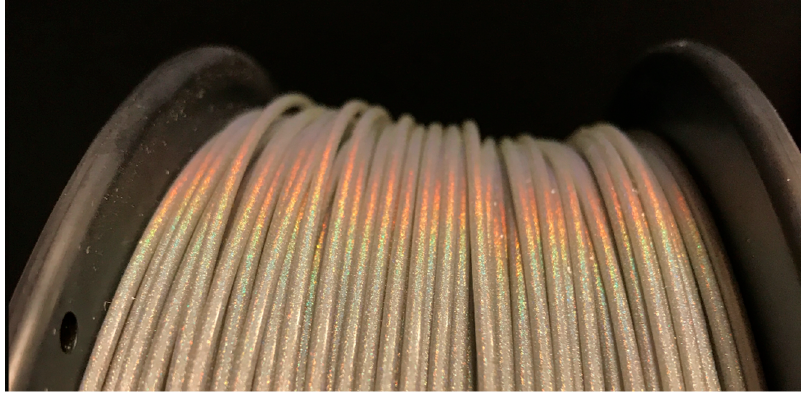
Figure 1. Picture of an ABS (acrylonitrile-butadiene-styrene copolymer) filament (MAXITHEN® SAN702767/10 Metallic Silver).